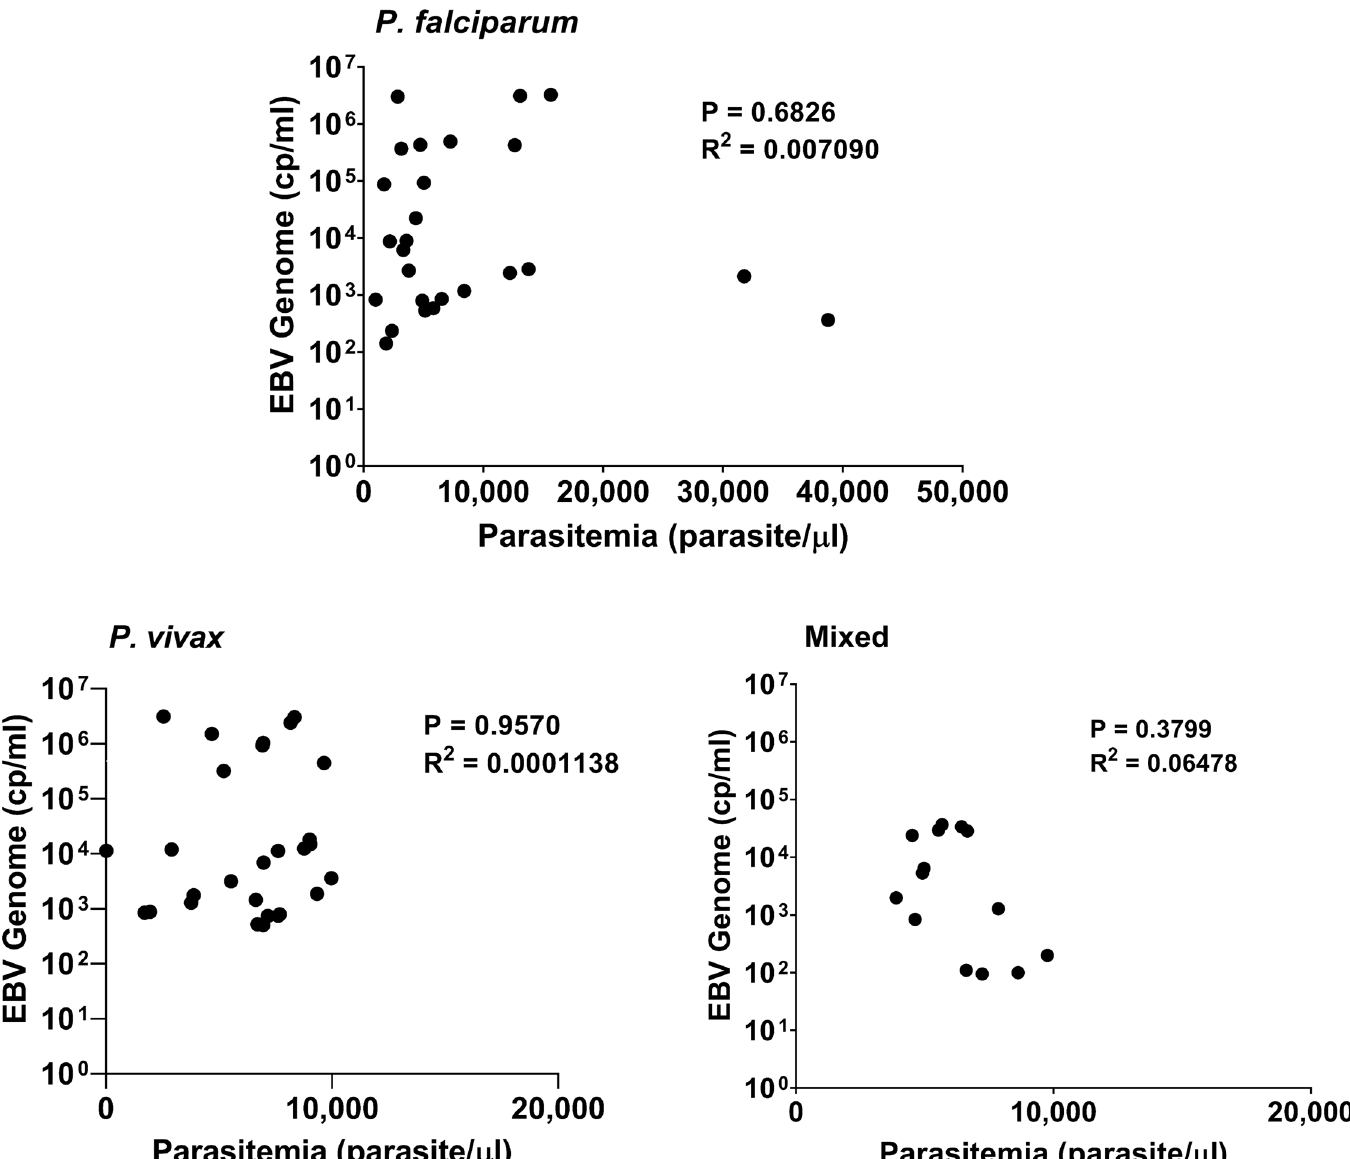
Fig 3. Comparison of Parasitemia versus EBV genome levels in Malaria cases; (a) P . falciparum , (b) P . vivax , (c) Mixed. Statistical analysis (R 2 ) was done by linear regression.